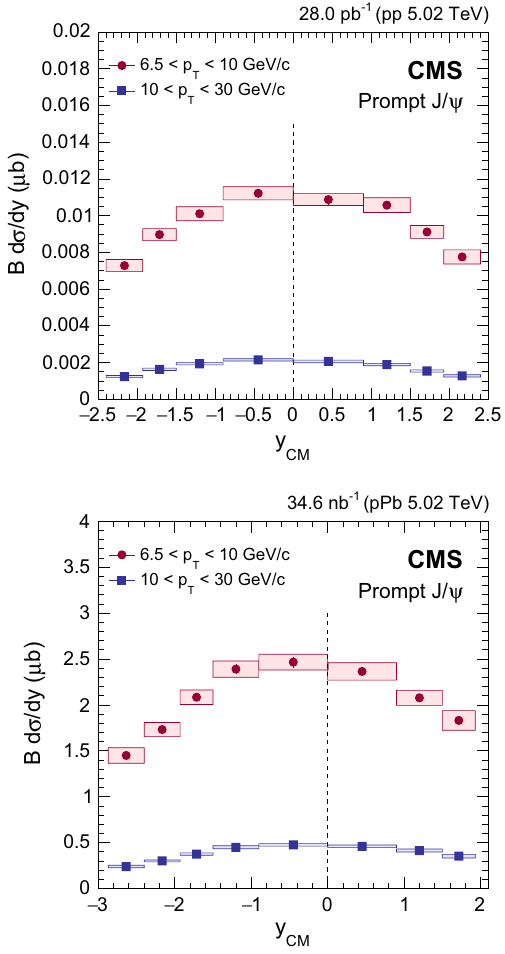
Fig. 3 Rapidity dependence of the cross section (multiplied by the dimuon branching fraction) for prompt J /ψ mesons in the p T inter- vals of 6 . 5 < p T < 10GeV / c ( circles ) and 10 < p T < 30GeV / c ( squares ) in pp ( upper ) and pPb ( lower ) collisions. The vertical dashed line indicates y CM = 0. The vertical bars (smaller than the symbols in most cases) represent the statistical uncertainties and the shaded boxes show the systematic uncertainties. The fully correlated global uncer- tainty from the integrated luminosity determination, 2.3% for pp and 3.5% for pPb collisions, is not included in the point-by-point uncertain-